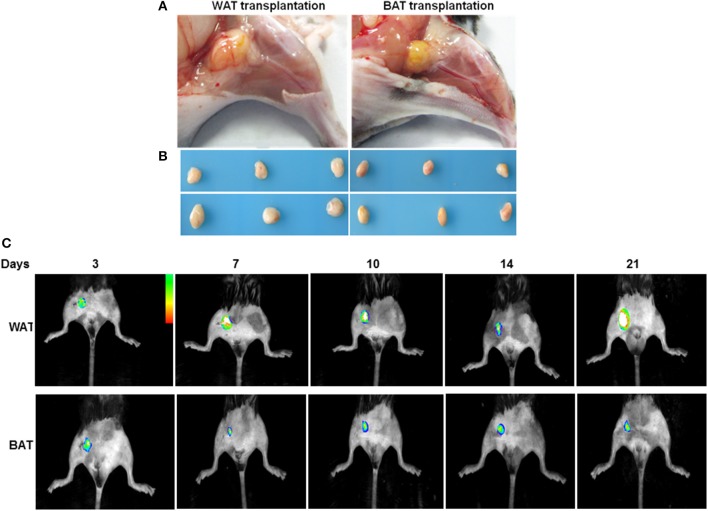
Adipose tissues 21 days after transplantation. (A) The depot (yellow, at center, originally 50 mg) subcutaneously transplanted over the adductor muscle region. (B) Adipose tissue depots 21 days after transplantation. Representative images of transplanted AT at the completion of the treatment protocol. (C) Transplanted eGFP pads were imaged by capturing fluorescence signal using an in-vivo Imaging System at indicated time points.